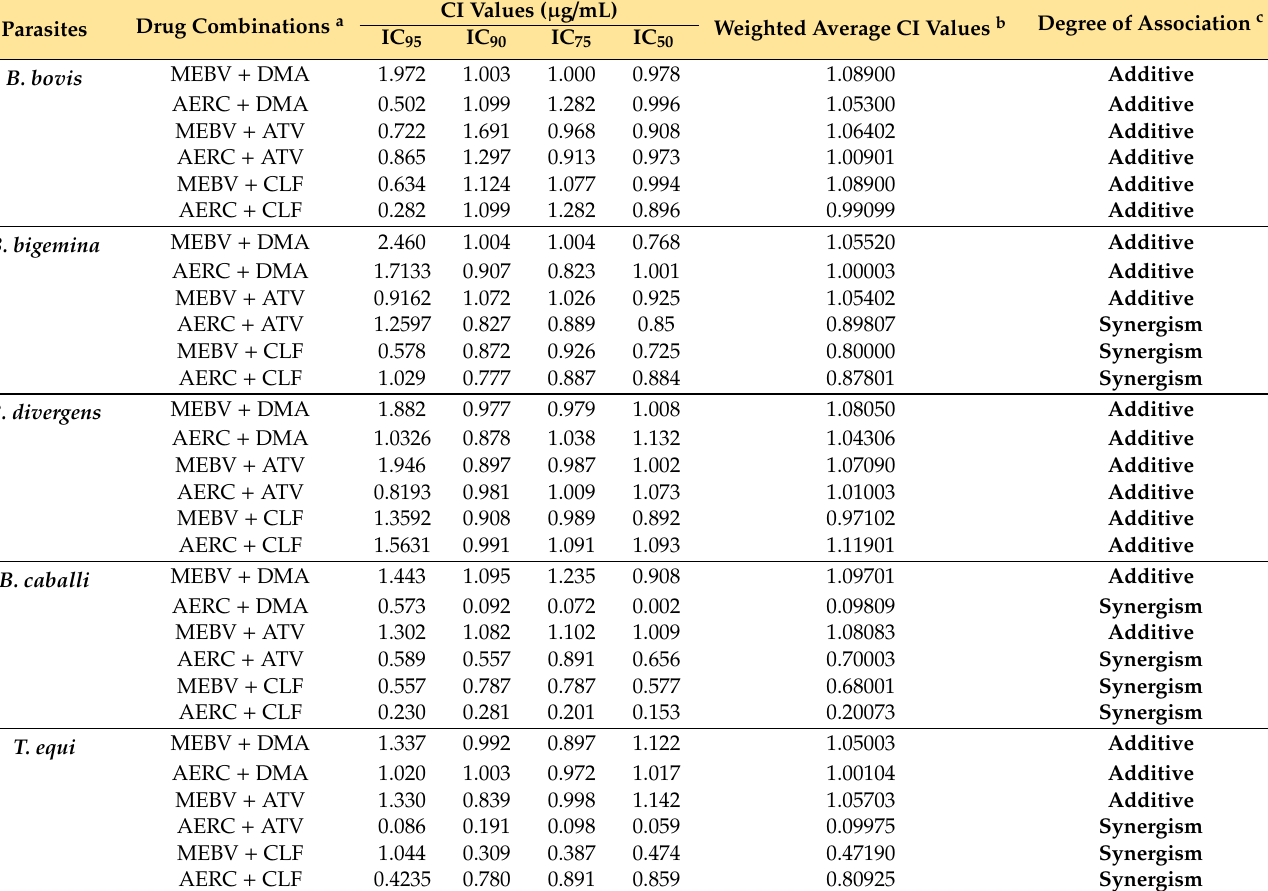
Table 4. Combination e ff ect of MEBV and AERC with DMA, ATV, and CLF in